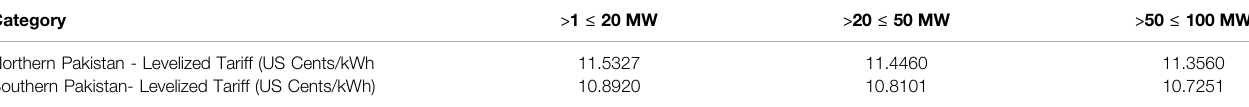
TABLE 3 | NEPRA approved a 25-years solar PPA in